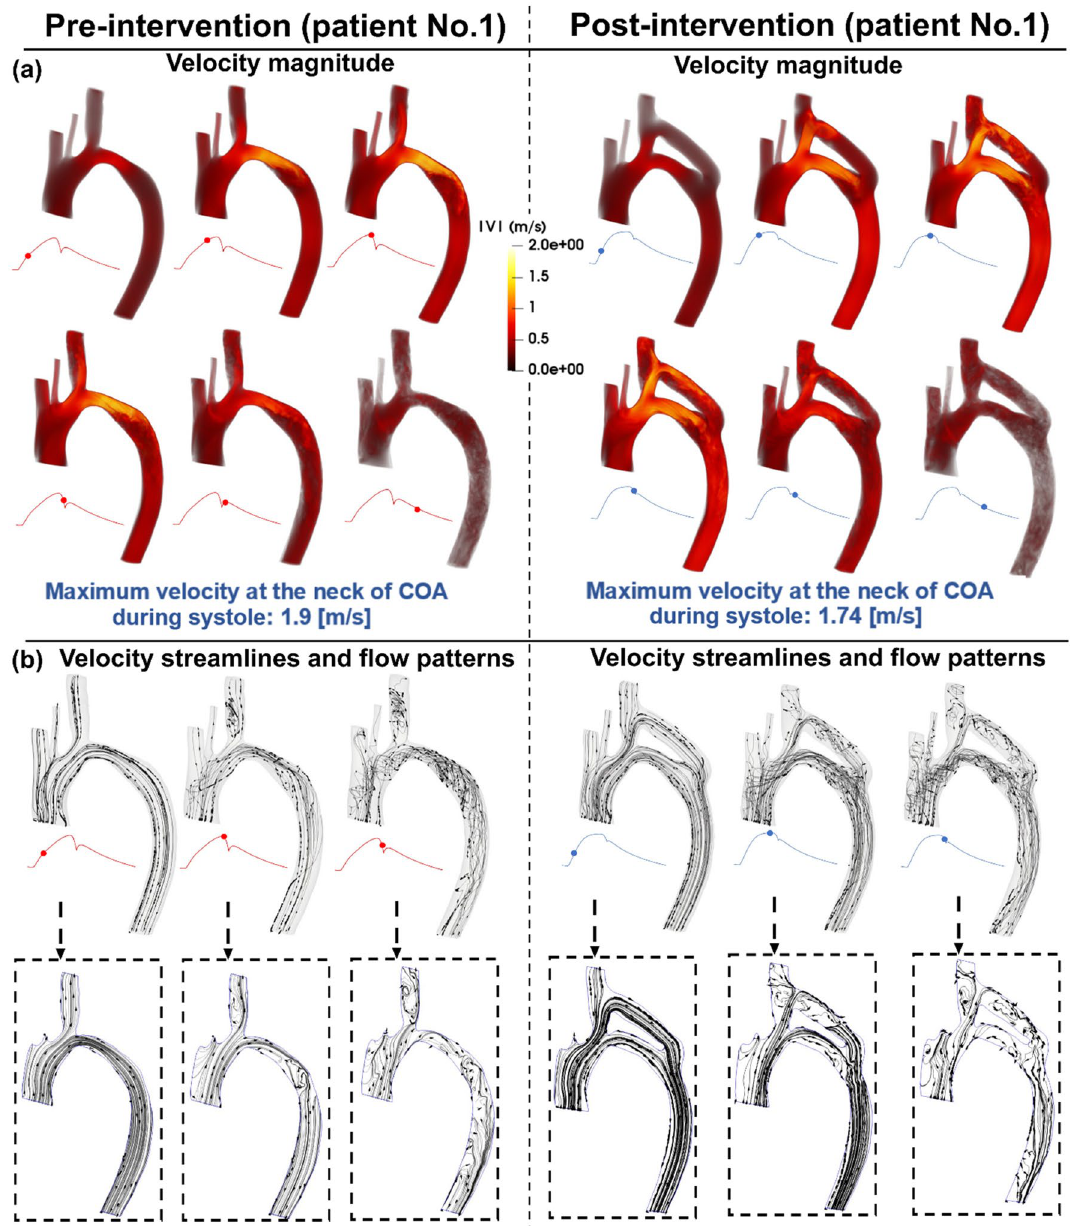
Figure 3. Flow modeling in Patient No. 1 in pre and post intervention status. ( a ) Time-evolving velocity magnitude at six instances; ( b ) 3-D (upper row) and 2-D (lower row) streamlines through the aorta at three instances. Baseline characteristics (Patient No. 1): mild-moderate aortic stenosis, mild aortic valve regurgitation, trace mitral regurgitation, COA and systole, which was much greater than pre-intervention (0.022 [m 3 /s] at peak systole). Patient #2 (Fig. 6, panel A) displayed slightly elevated VSS in all regions of the aorta at peak systole compared to early systole, with a more substantial increase at the outlet of the graft. Maximum VSS recorded for patient #2 was 0.014 [m 3 /s] which was slightly improved when compared to the pre-intervention status (0.018 [m 3 /s]). Patient #3 (Fig. 7, panel A) exhibited similar VSS patterns to pre-intervention, with increased VSS upstream, at the neck, and downstream of the COA reaching a maximum of 0.026 [m 3 /s] in post-intervention status at peak systole which was slightly improved from pre-intervention (0.030 [m 3 /s]). All three patients exhibited a similar behavior with regards to VSS in the late systole as the patterns remained similar to peak systole with smaller magnitudes. Turbulent characteristics. While blood flow is generally laminar in healthy vessels, it may experience transition to turbulence under pathophysiological conditions. In this study, turbulent kinetic energy (TKE) and